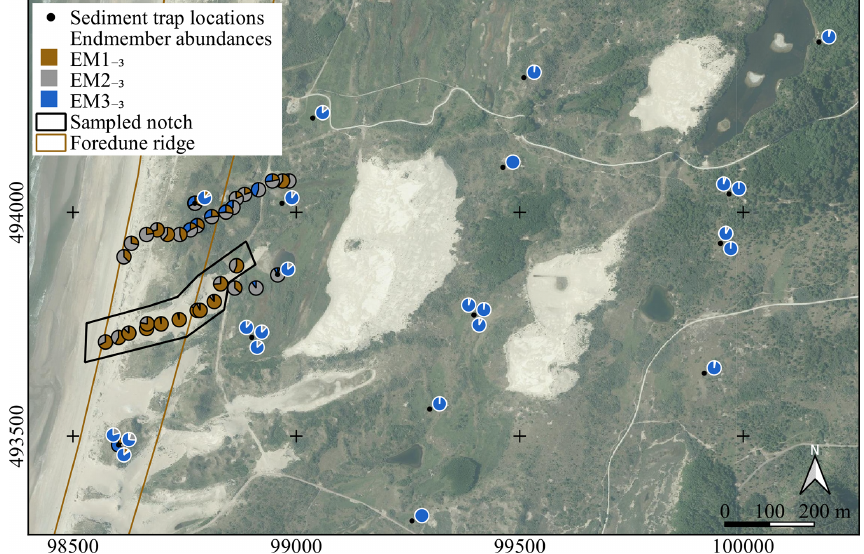
Figure 11. Pie charts showing abundances of the 3EM solution computed for the ConD2d distributions of the aeolian dune dataset. Pie charts with a black outline denote surface samples and are plotted at the sampling location. Pie charts with a white outline denote sediment-trap samples and are plotted near the sampling location. The exact locations of sediment traps are marked by black dots. Two of the subregions defined in Fig. 1c are shown in simplified form. Aerial photograph © PDOK.nl, 2017.